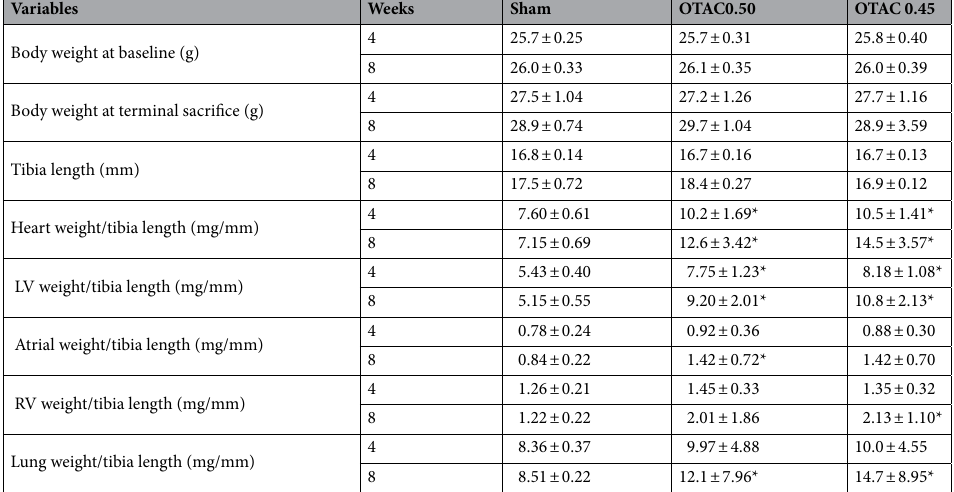
Table 1. Physical characteristics of mice subjected to O-TAC and sham procedures. Data are expressed as the mean ± standard error of the mean. Physical characteristics in sham-operated and O-ring-induced transverse aortic constriction (OTAC) mice. O-rings had inner diameters of 0.50 mm (OTAC0.50) and 0.45 mm (OTAC0.45). n = 14 in the Sham group; n = 14 in O-TAC0.50 group; n = 9–13 in O-TAC0.45 group. Terminal sacrifice was performed in 4 weeks and 8 weeks after procedures. LV left ventricular, RV right ventricular. One- way analysis of variance (ANOVA) with Tukey’s post hoc tests were used (* P < 0.05 vs. sham).